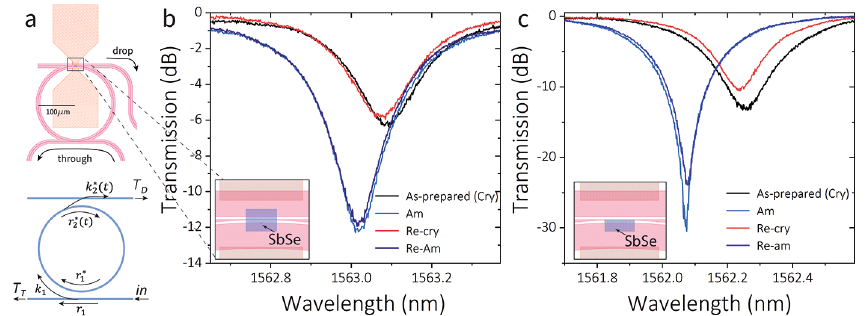
Fig. 4 Extinction ratio tuning via phase-shift triggered coupling coefficient modulation. a Schematic of the ring resonators under test with a drop port at the phase shifter position and the corresponding modulation of the cou- pling coefficients k and r . b Experimental results for the device’s through port for two switching cycles of a Sb 2 Se 3 cell placed on the ring waveguide only, as shown in the inset. c Same as b for a Sb 2 Se 3 cell covering both the ring waveguide and the drop port with nearly 20 dB modulation in